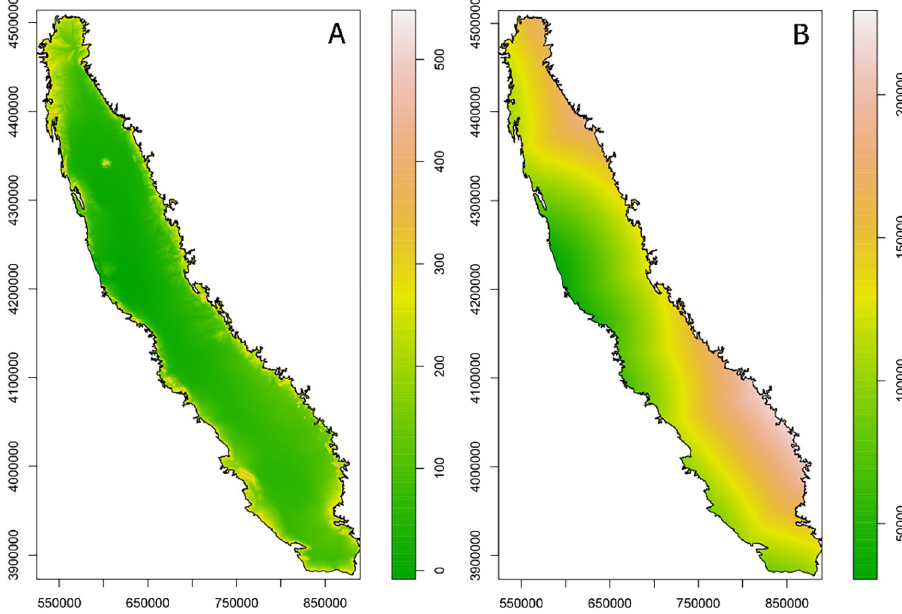
Fig 2. Flat projection (WGS84 zone 10) of auxiliary variables elevation in meters (A) and distance to the coast in meters (B) used for kriging thermal time, chill accumulation and phenology